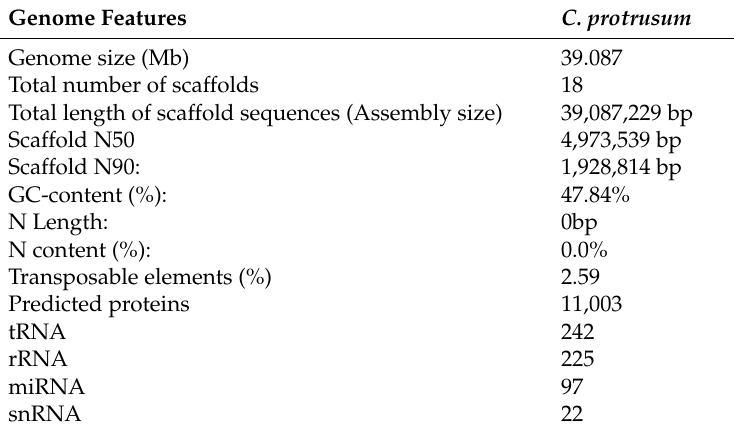
Table 1. The genome features of C. protrusum .